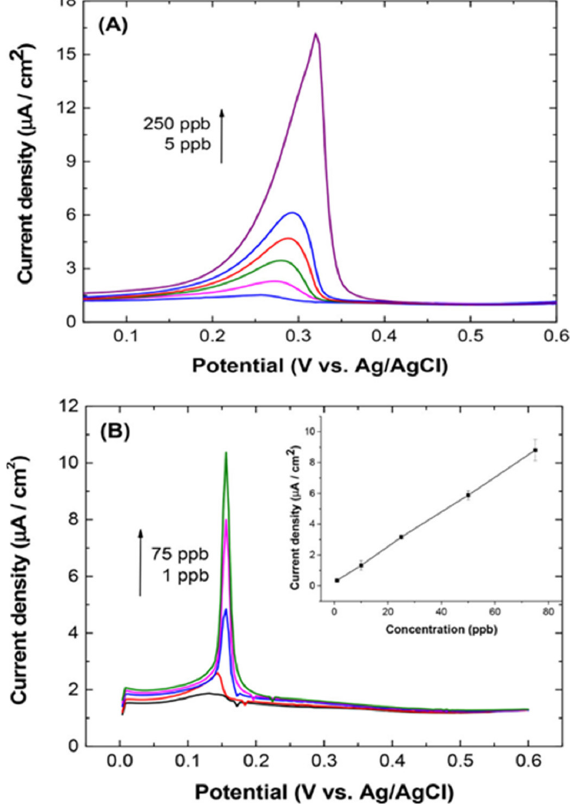
Figure 2. Differential pulse anodic stripping voltametric (DPASV) I − E curves for standard solutions